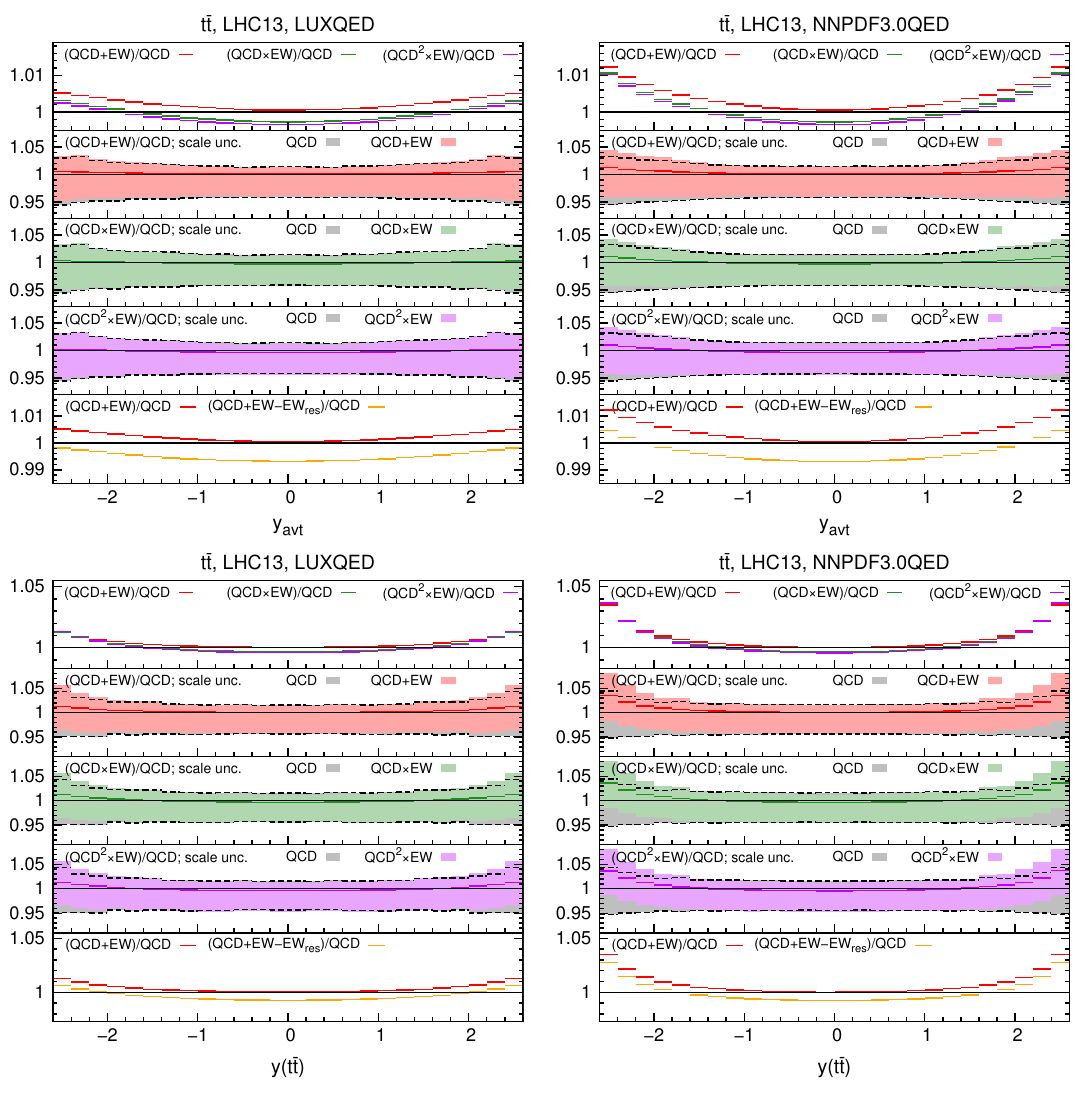
Figure 5 . As in (cid:12)gure 4 but for the y avt and y ( t (cid:22) t ) di(cid:11)erential